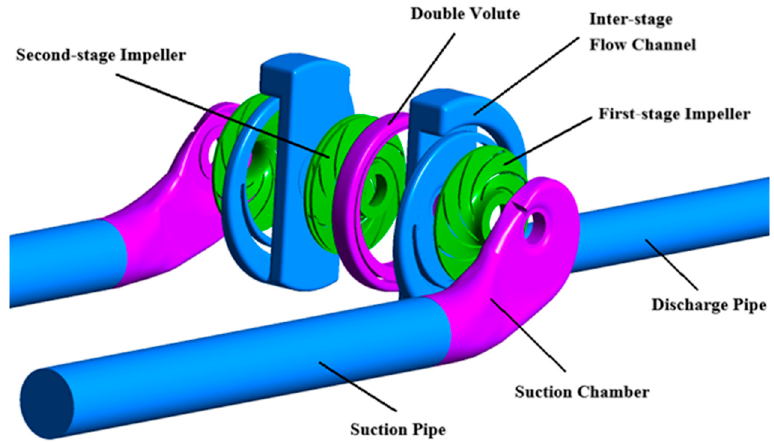
Figure 1. Computational domain of the multi-stage double-suction centrifugal pump.